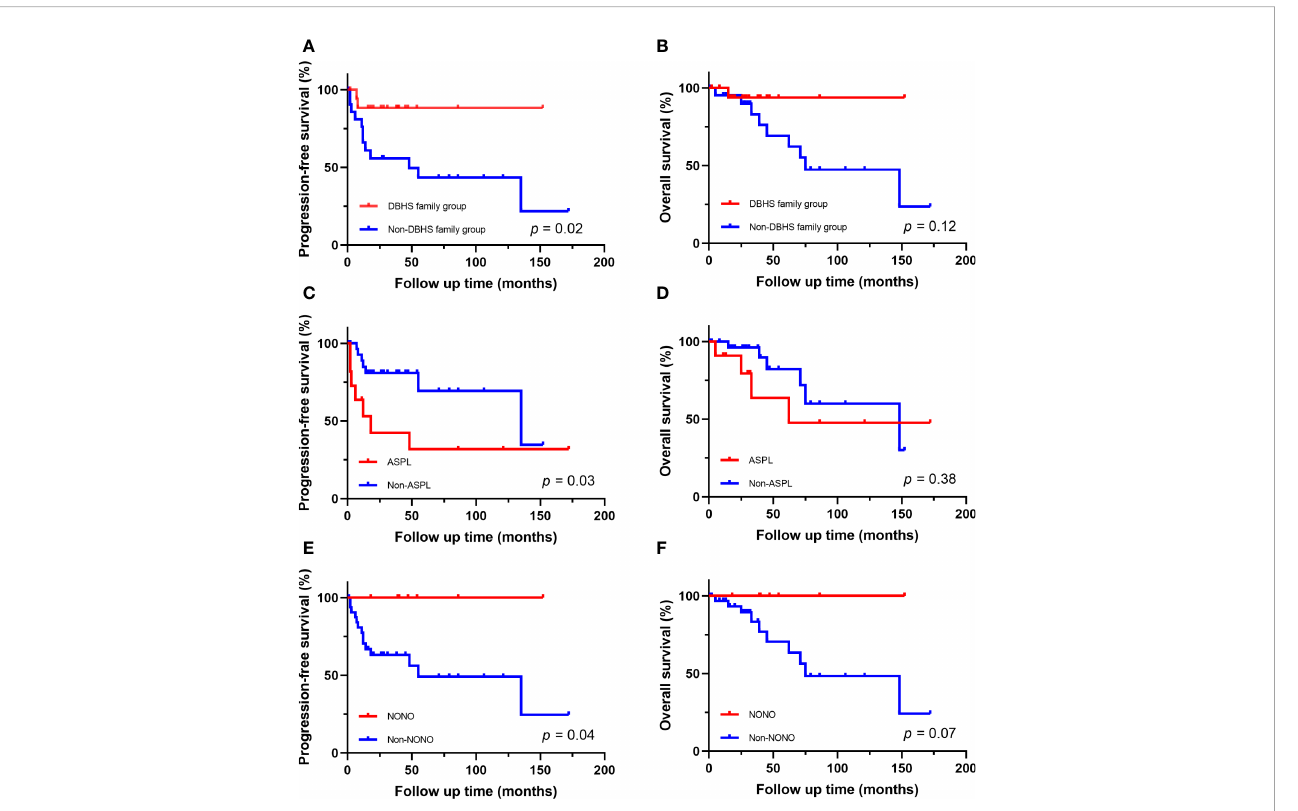
FIGURE 4 Survival analysis of different fusion partners. (A, B) PFS and OS for patients in DBHS famliy group and non-DBHS famliy group. (C, D) PFS and OS for patients with ASPL-TFE3 fusion and non-ASPL fusion. (E, F) PFS and OS for patients with NONO-TFE3 fusion and non-NONO fusion.